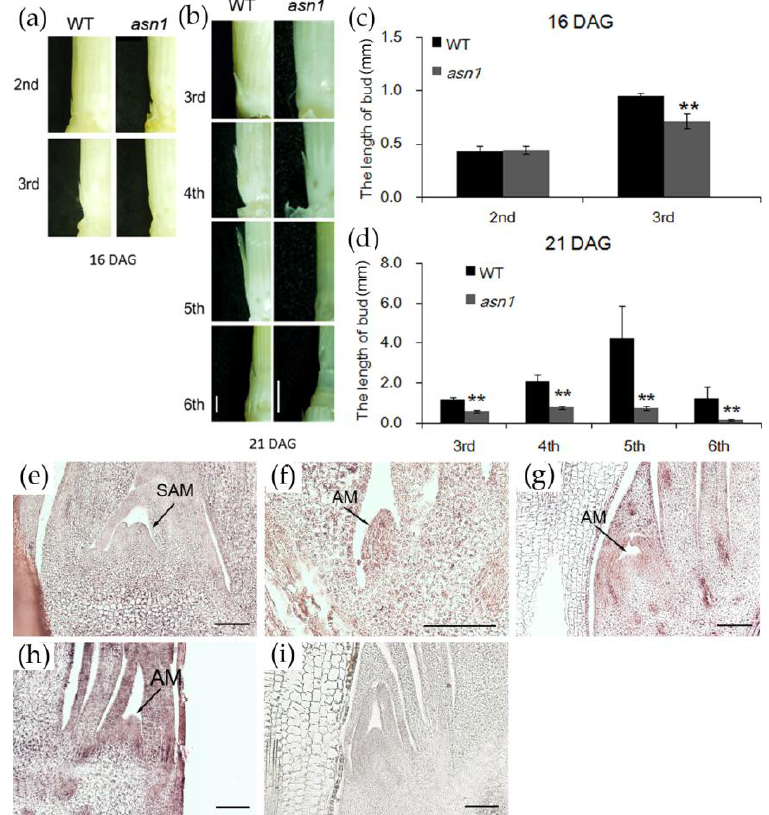
Figure 6. Comparison of tiller bud outgrowth in WT and asn1 . ( a ) Tiller buds in the axil of second and third oldest leaves, 16 days after germination (DAG); ( b ) tiller buds in the axil of third, fourth, fifth, and sixth oldest leaves, 21 DAG; ( c )the length of buds in ( a ); ( d ) the length of buds in ( b ). Data are means ± SD ( n ≥ 8). Significant differences were determined by ANOVA (** p < 0.01). The scale bar is 1 mm; ( e ) expression pattern of OsASN1 by RNA in situ hybridization, detection of OsASN1 transcripts in shoot apical meristem (SAM); ( f – h ) detection of OsASN1 transcripts in axillary meristem (AM) from early to late stages; ( i ) RNA in situ with sense probe. The scale bar is 100 μm.